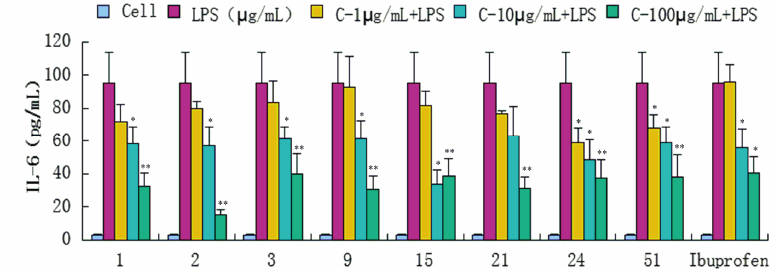
Figure 6. Inhibitory effects of compounds 1 , 2 , 3 , 9 , 15 , 21 , 24 and 51 (1, 10, 100 μ g/mL) on IL-1 β production stimulated by LPS (10 μ g/mL) in RAW 264.7 cells (mouse leukemic monocyte macrophage cell line). Data are expressed as mean ± S.E.M. of three independent experiments. Cell: cultures were not exposed to lipopolysaccharide (LPS); LPS: cultures were subjected to LPS; LPS + Drug: Compounds were added to the cultures during LPS; Positive control: LPS + Ibuprofen. * p < 0.05 vs. LPS; ** p < 0.01 vs. LPS.